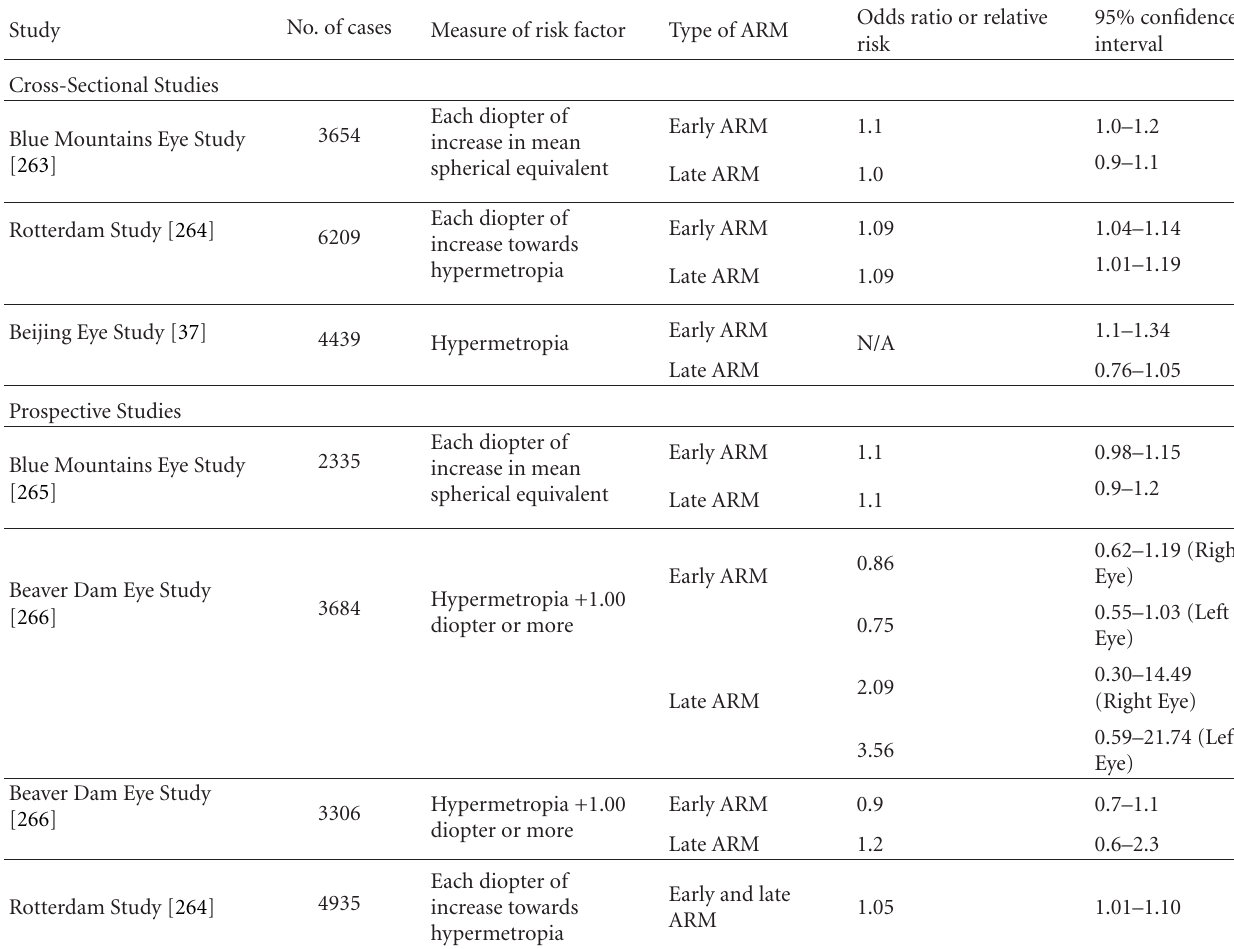
Table 16: Studies investigating the relationship between refractive error and risk for